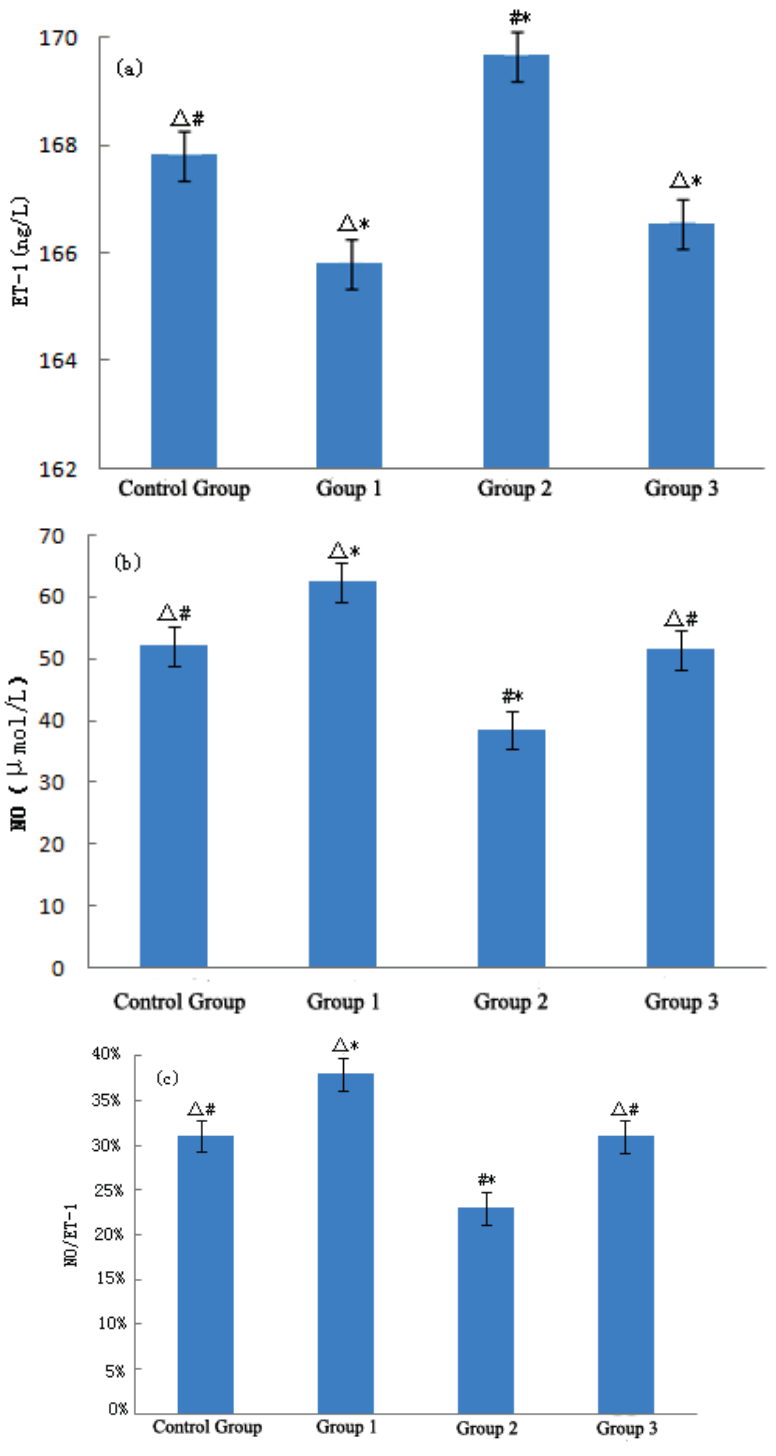
Figure 2. Variations of ET-1 ( a ), NO ( b ), and NO/ET-1 ( c ) in mice. Compared with the control group, * p < 0.01; Compared with the heat wave group, # p < 0.01; Compared with the temperature drop group, △ p <